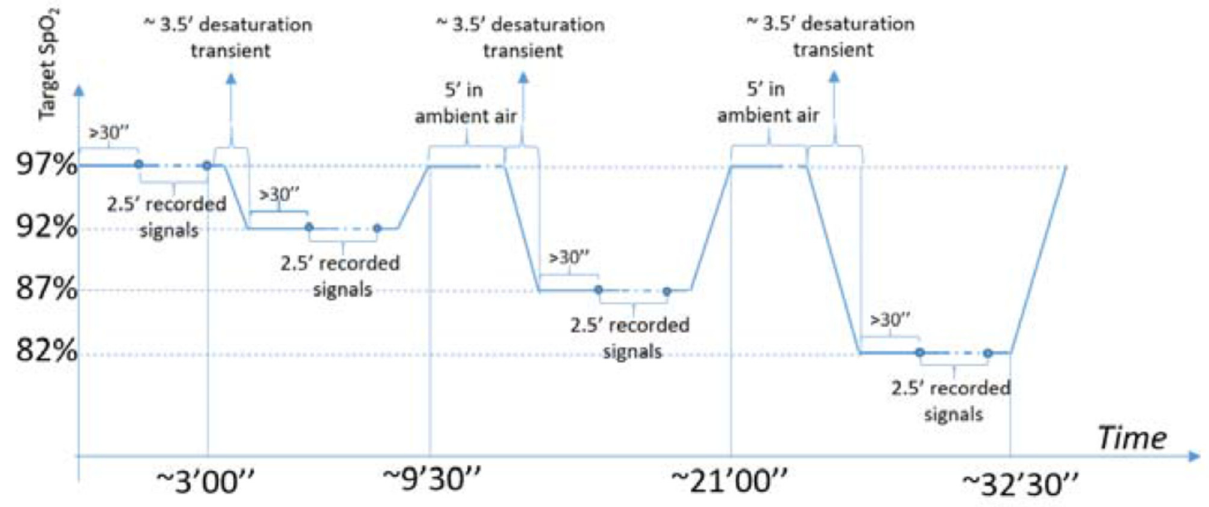
Figure 3. Diagram of the study protocol.